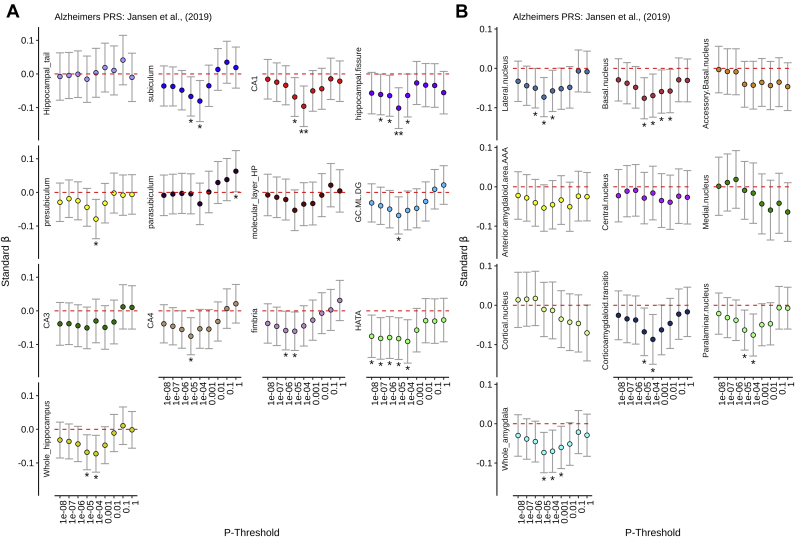
Standardized β coefficients (Y-axis) for Alzheimer's disease PRS (controlling for demographic and genetic confounds) across a range of p thresholds (X-axis) for (A) hippocampal and (B) amygdala subregions. ∗Nominal significance (pUNCORRECTED < 0.05), ∗∗Survival for FDR (pFDR < 0.05).